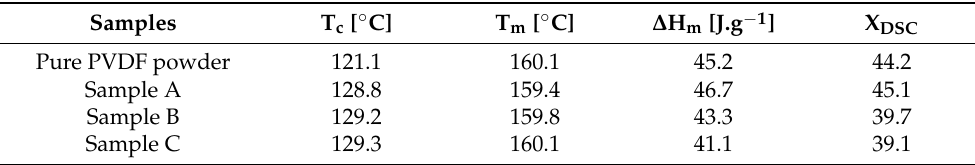
Table 3. DSC analysis of the pure PVDF powder and electrospun fibers, samples A, B and C. T m : Melting temperature; ∆ H m : enthalpy of fusion and X DSC : degree of